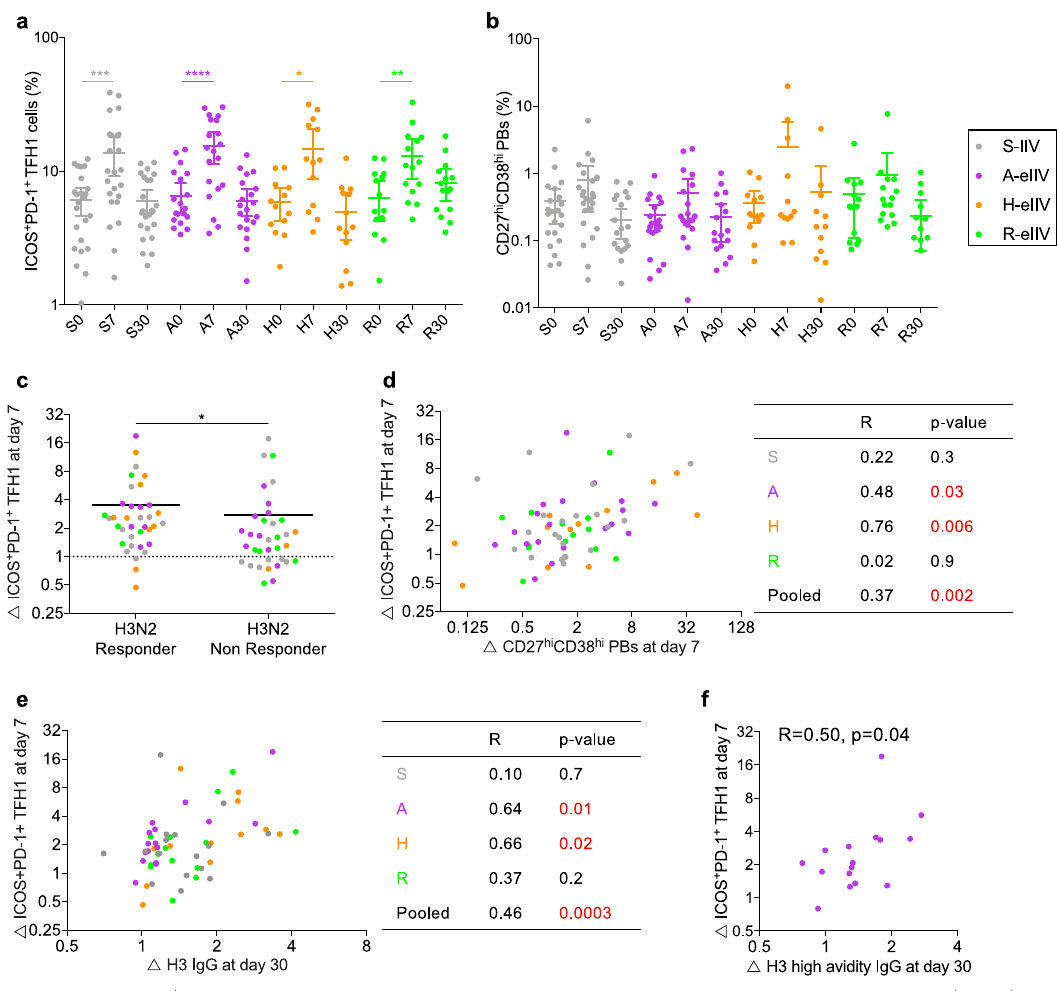
Fig. 3 Interplay between CD4 + T follicular helper cells and humoral responses. The frequency of a activated ICOS + PD-1 + TFH1 cells and b CD27 hi CD38 hi plasmablasts, signi fi cant by Friedman ’ s test. c Fold induction of ICOS + PD-1 + TFH1 cells by A(H3N2) HAI seroconversion status, the signi fi cance by Mann – Whitney t test. d Spearman ’ s correlation between the fold induction of ICOS + PD-1 + TFH1 and plasmablasts at day 7, e H3-2013 HA-speci fi c IgG and f high-avidity H3-2013 HA-speci fi c IgG, at day 30. Data represented as mean (S, n = 24; A, n = 20; H, n = 13; R, n = 15) with 95% CI; * p < 0.05, ** p < 0.01, *** p < 0.001, **** p < 0.000. TFH1 type-1 T follicular helper, PB